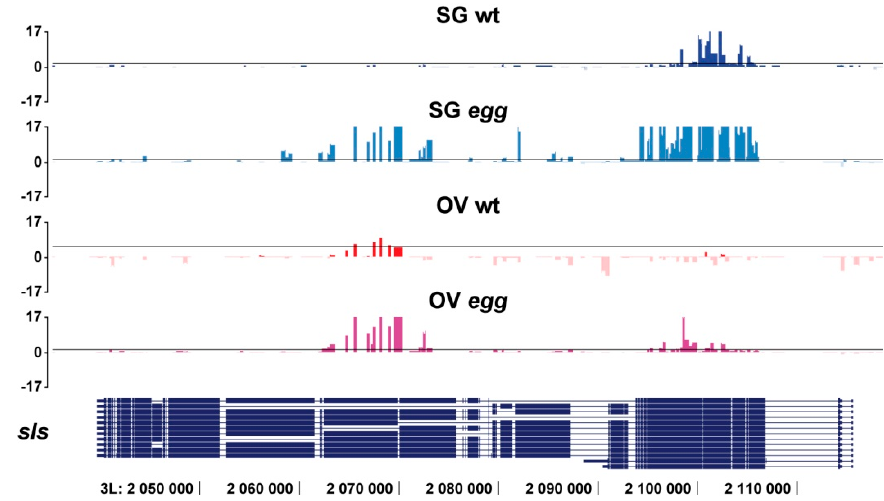
Figure 2. SU(VAR)3-9 profiles in the sls gene in salivary glands (SG) and germline of whole juvenile ovaries (OV) from wild type (wt) and egg mutants. Data for SG wt are taken from [28], other profiles are obtained in this study. Significance of binding of SU(VAR)3-9-Dam (values above X axis) or Dam (values below X axis) as a − log 10 of p -value is plotted on the Y axis. Black horizontal lines denote threshold p -value corresponding to the FDR < 5%. Genomic coordinates on the X axis and intron / exon structure of the sls gene correspond to the BDGP Release 6.